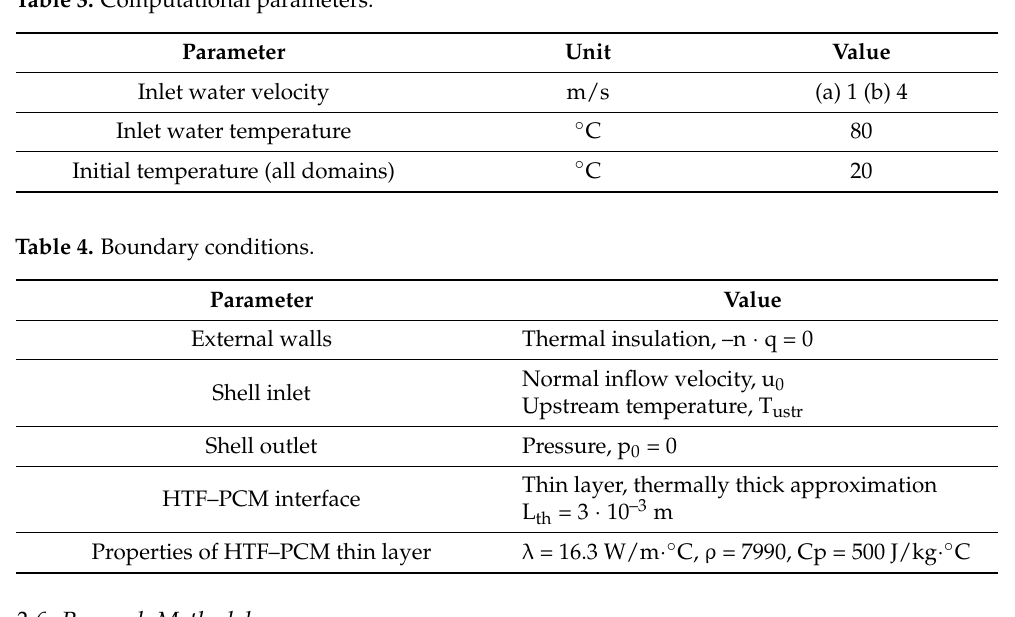
Table 3. Computational parameters.